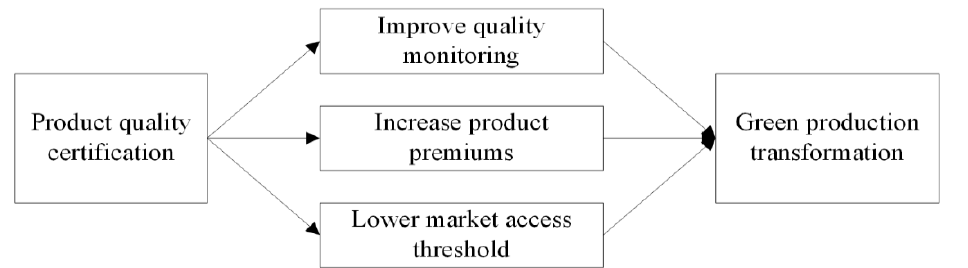
Figure 1. The pathway underlying the impact of product quality certification on the transition of green production.